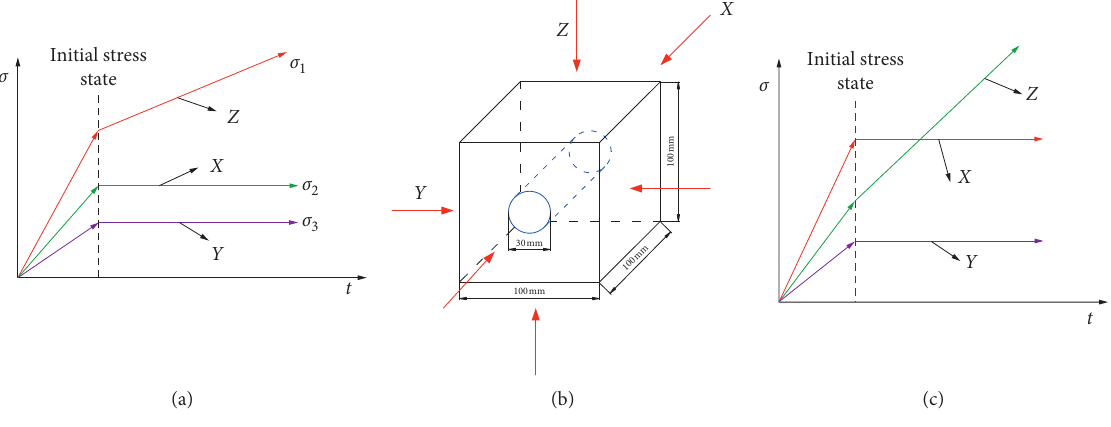
Figure 7: True-triaxial loading stress